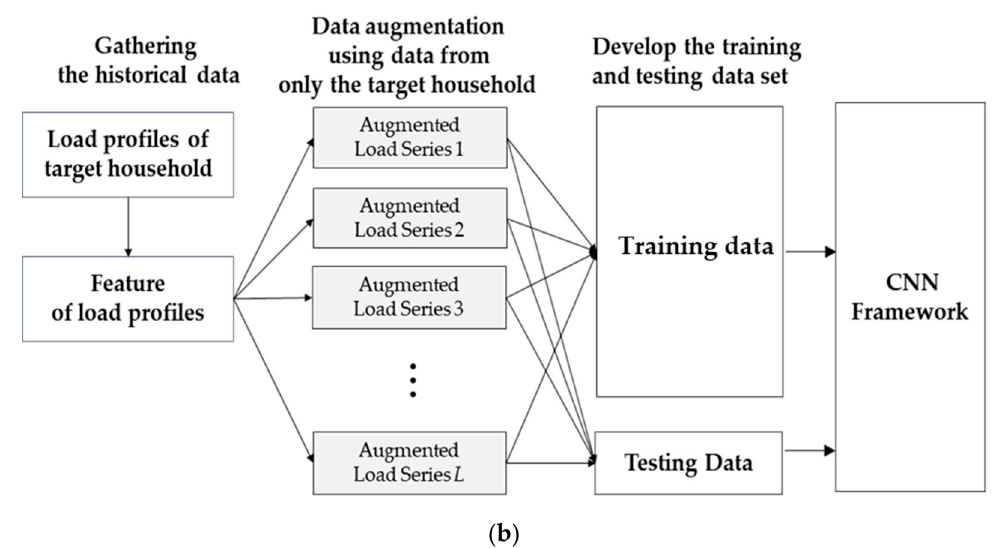
Figure 1. Comparison of data augmentation strategies: ( a ) pooling technique and ( b ) proposed augmentation technique.